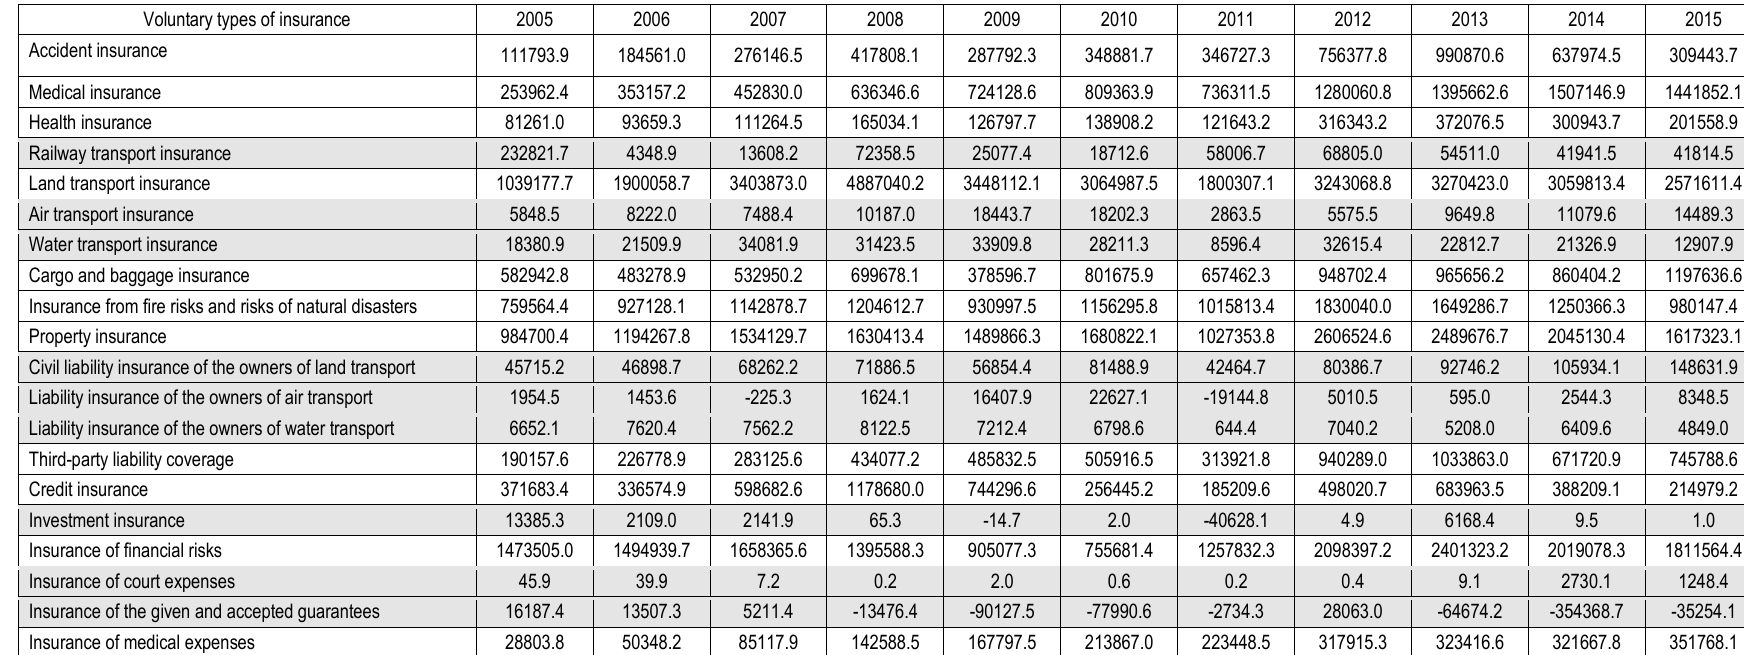
Table 1. Net income of insurance premiums for certain types of insurance in 2005 – 2015, thousand UAH